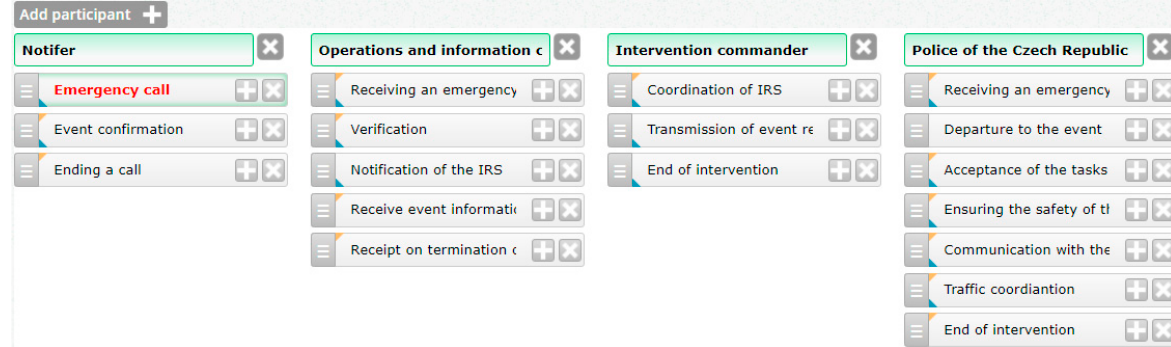
Figure 4. Tabular view.